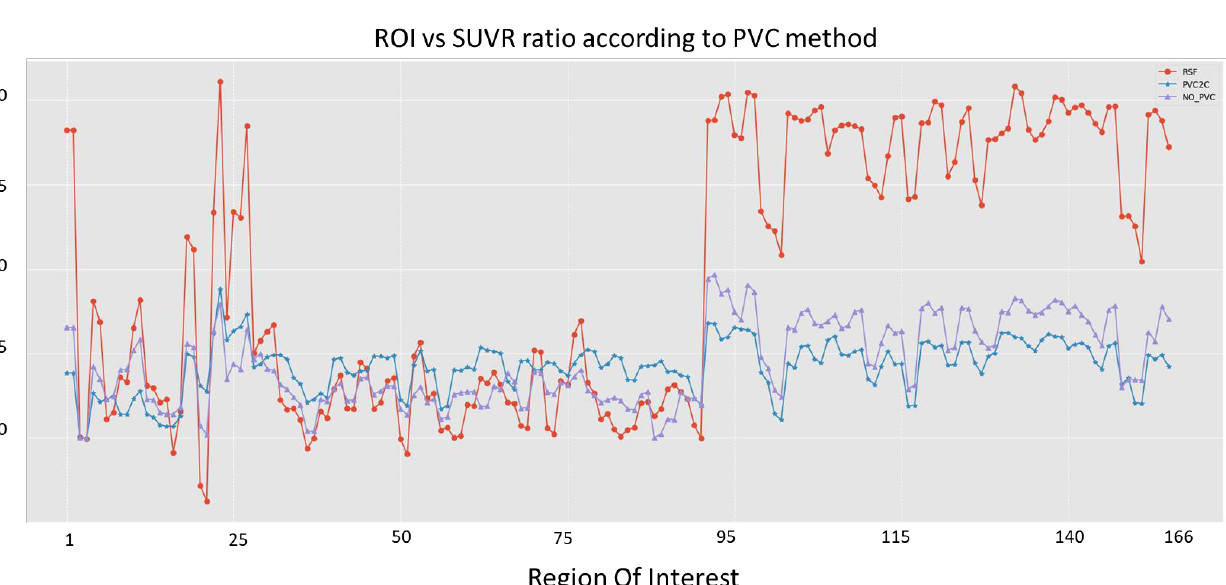
Table 2. Values of cognitive impairment obtained for each cluster in terms of the MMSE. MMSE p -Value